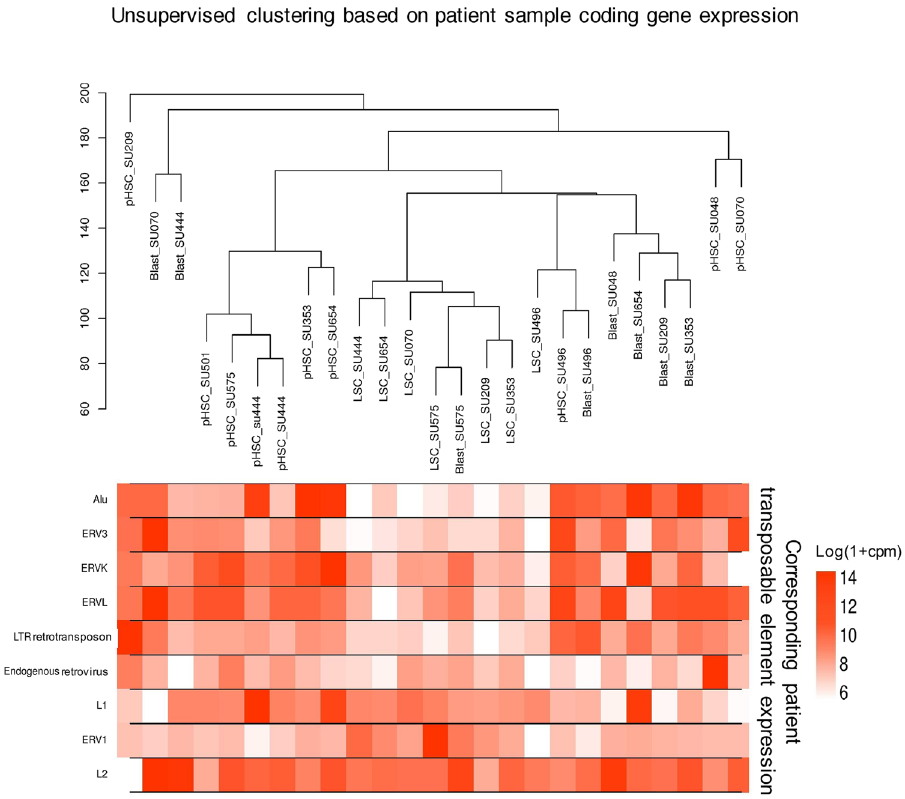
Figure 3. Unsupervised hierarchical clustering of coding gene expression in patient samples and the expression levels of the corresponding transposable elements (a) The image on top depicts the hierarchical clustering of each group (pHSC, LSC, and Blast) based on the average Euclidean distance for the coding gene expression in the patient samples. Below each sample, the expression of the corresponding TE Types (Alu, ERV3, ERVK, ERVL, LTR Retrotransposon, Endogenuous Retroviruses, L1, ERV1, and L2) is shown. The TE expression is expressed in units of normalized counts per million (CPM) of log10 (1 +